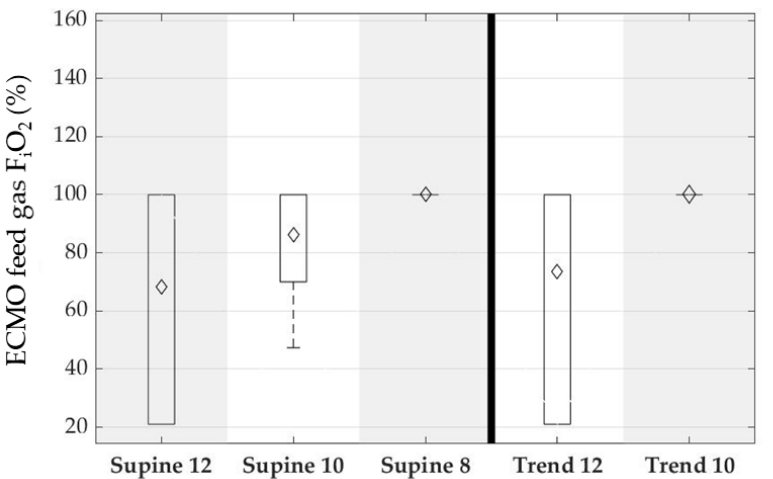
Figure 15. ECMO feed gas oxygen fraction for supine position and reverse Trendelenburg. Each column depicts one group of the experimental sequence. Supine: animal was positioned flat on the back; Trend: 45° reverse Trendelenburg position, simulating a mobilized patient; and 12,10,8: respiratory rate of the intermittent mechanical ventilation, simulating hypercapnic respiratory failure. Boxplots show 95%-CI (whiskers), 50%-interval (box), median (black bar), and mean (diamond).